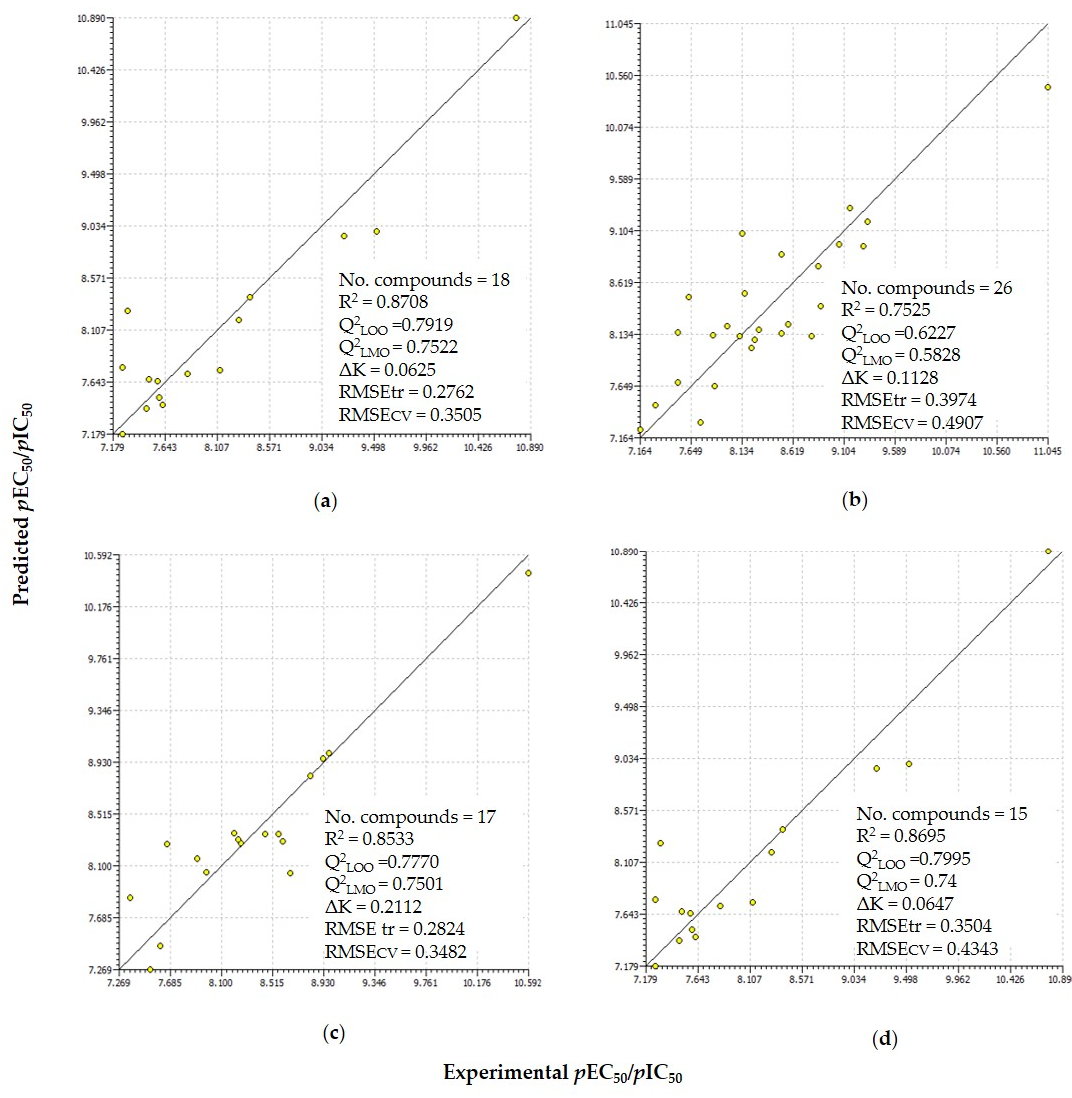
Figure 1. Scatter plots of the experimentally measured property and predicted activity obtained for four regression relations Equations (1), (2), (4), and (5) along with the statistical parameters for ( a ) agonist monazoles (thiazole / oxazole); ( b ) agonist diazoles (imidazoles and benzimidazole); ( c ) antagonist diazoles (imidazoles and benzimidazole); and ( d ) antagonist triazoles.